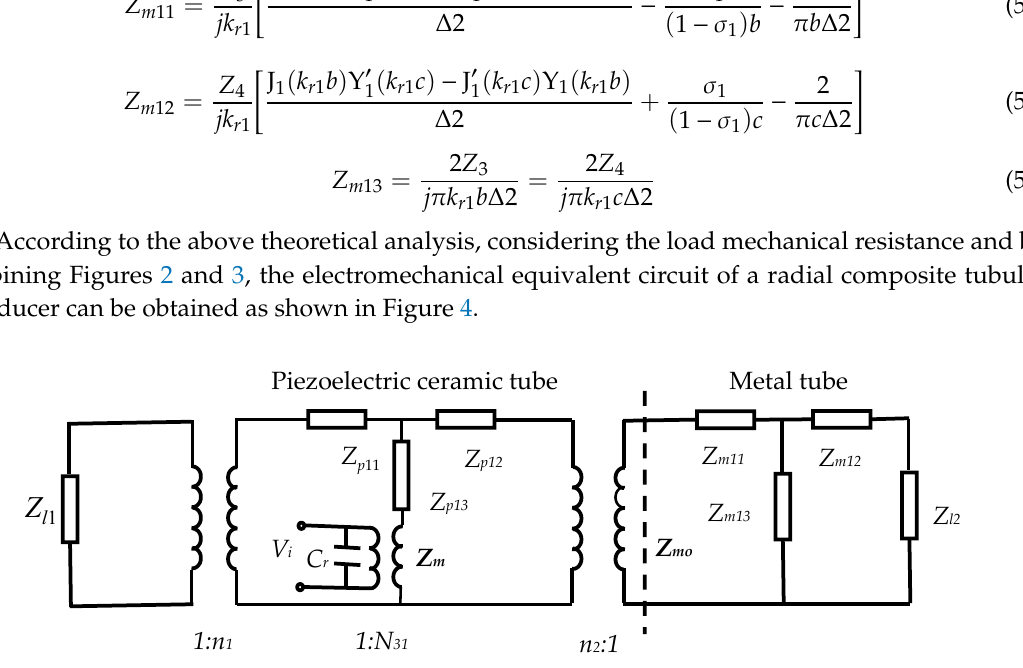
Figure 4. Electromechanical equivalent circuit of a radial composite tubular transducer.